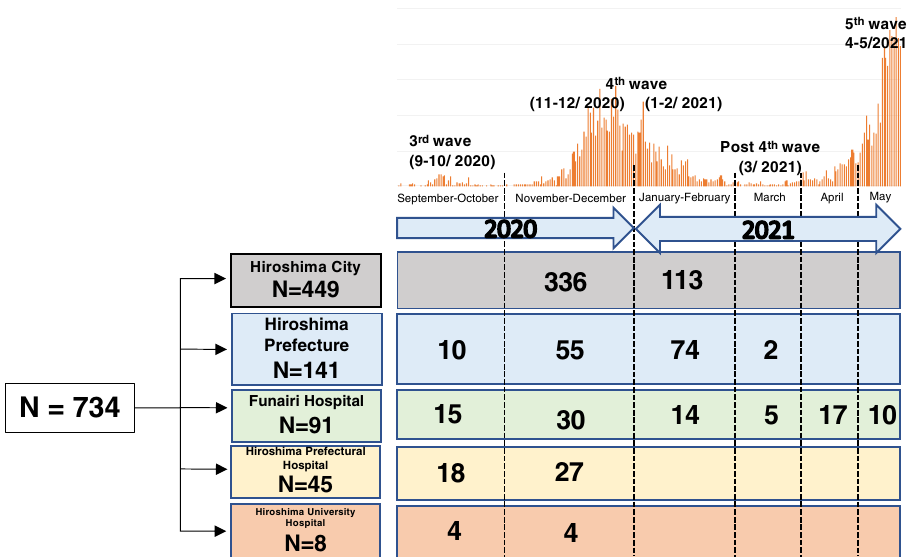
Figure 1. Flow of study subjects in Hiroshima, Japan. The figure showed the sources of the study subjects included in this study during each wave outbreak of SARS-CoV-2 in